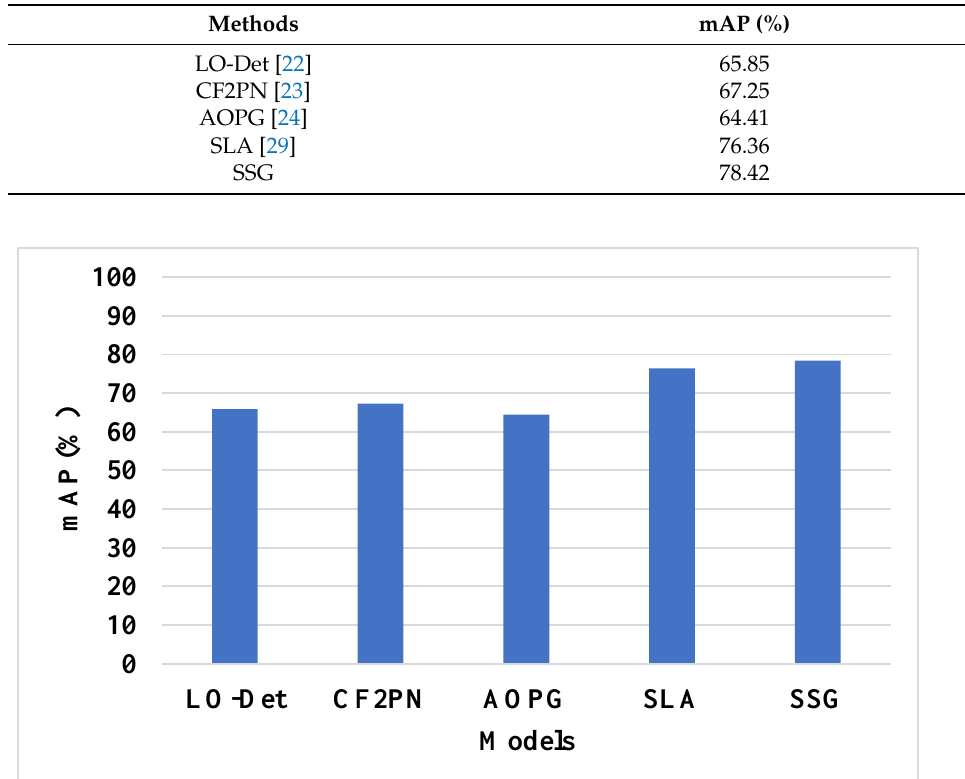
Table 6. Existing model comparison on DIOR dataset.